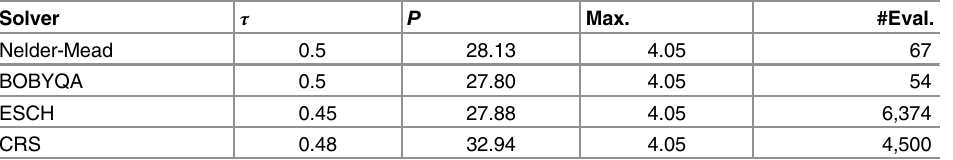
Table 1. Maxima found by different solvers for n = 100 inputs. Objective was to find the parameter combi- nation best fitting a human reference value using RMSD (fit optimization). Solver τ P Max.